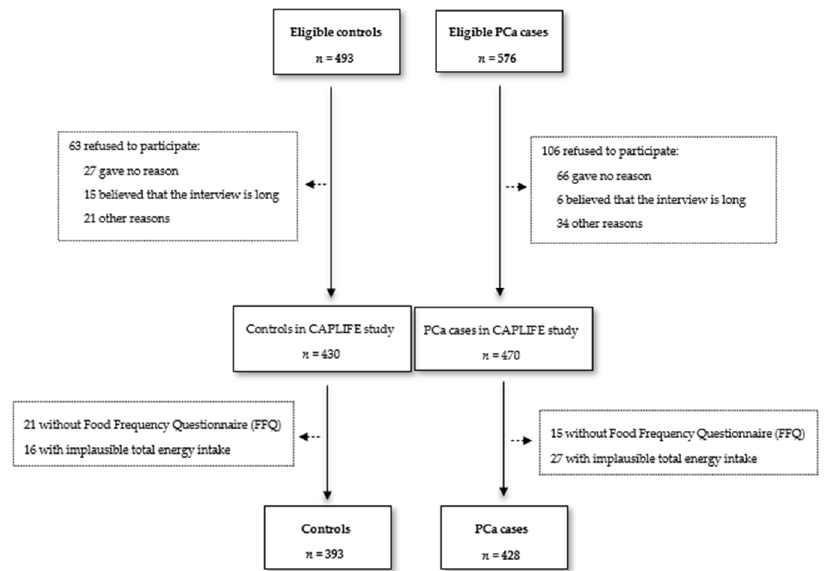
Figure 1. Flowchart CAPLIFE study.